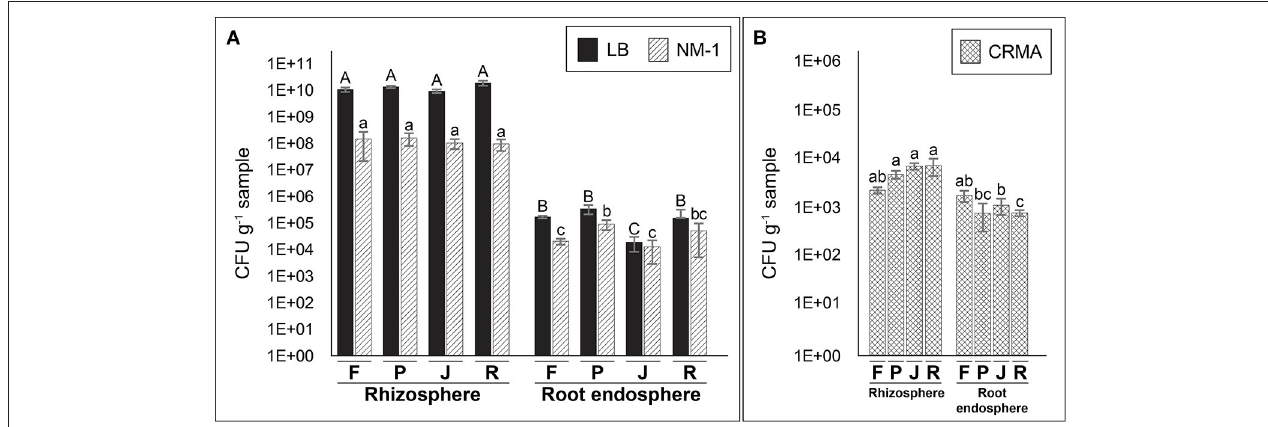
FIGURE 2 | Counts (CFU per g of sample) of total culturable (A) in rhizosphere and root endosphere samples of wheat plants using general (LB and NM − 1) and putative N 2 -fixing bacteria (B) with selective (Congo red malic–acid; CRMA) media. Samples labeled as F, P, J, and R correspond to Feña, Patras, Joker, and Rocky wheat cultivars, respectively. Error bars represent standard deviation and different lower letters denote statistical difference ( P ≤ 0.05, Tukey HSD test) ( n =